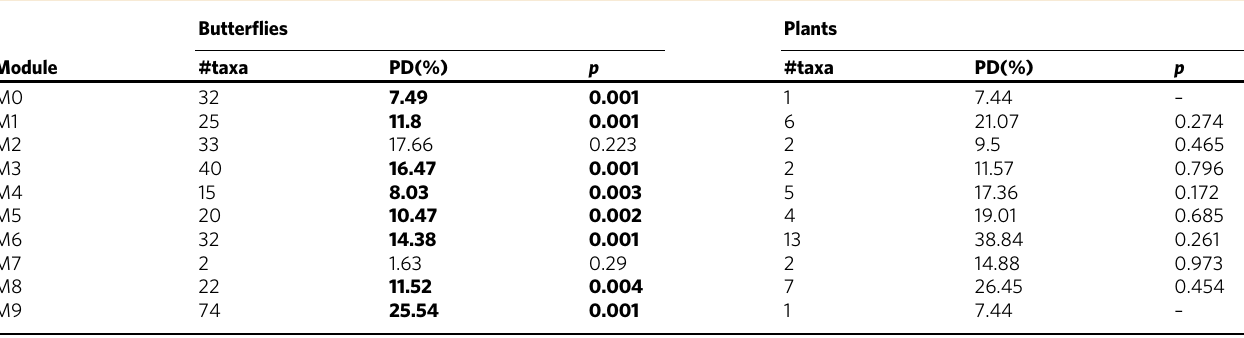
Assemblages with lower phyloglgenetic diversity than expected by chance are in